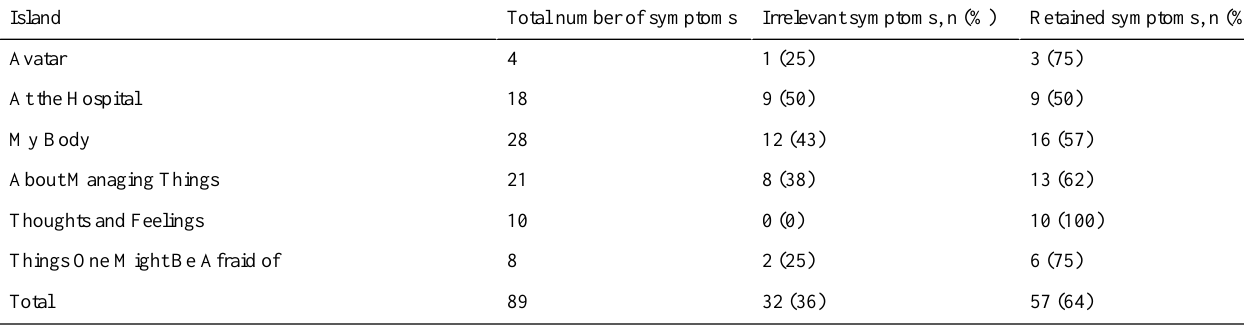
Table 4. Transferability of Sisom symptoms to the Sisom OI paper prototype.